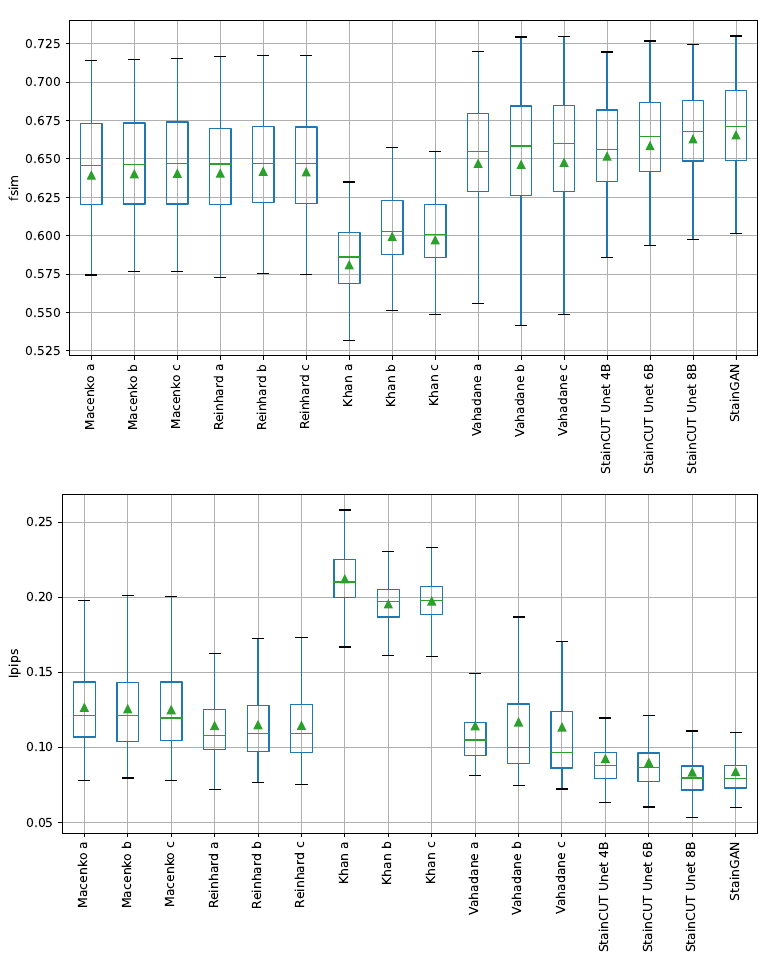
Figure A2. Boxplots of the evaluation of the FSIM and LPIPS metrics for all compared methods on the MITOS-ATYPIA dataset. Each box is drawn from the first to the third quartile. The horizontal lines represent the median value, and the triangle represents the mean. The whiskers indicate the minimum and maximum value of the